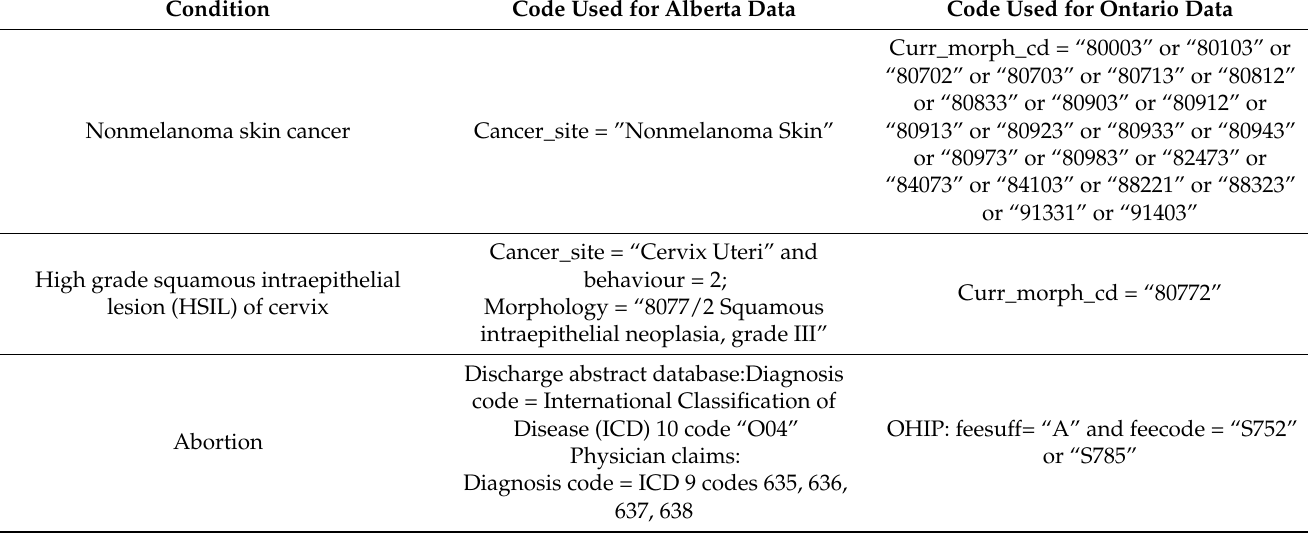
Table A1. Codes Used to Identify Study